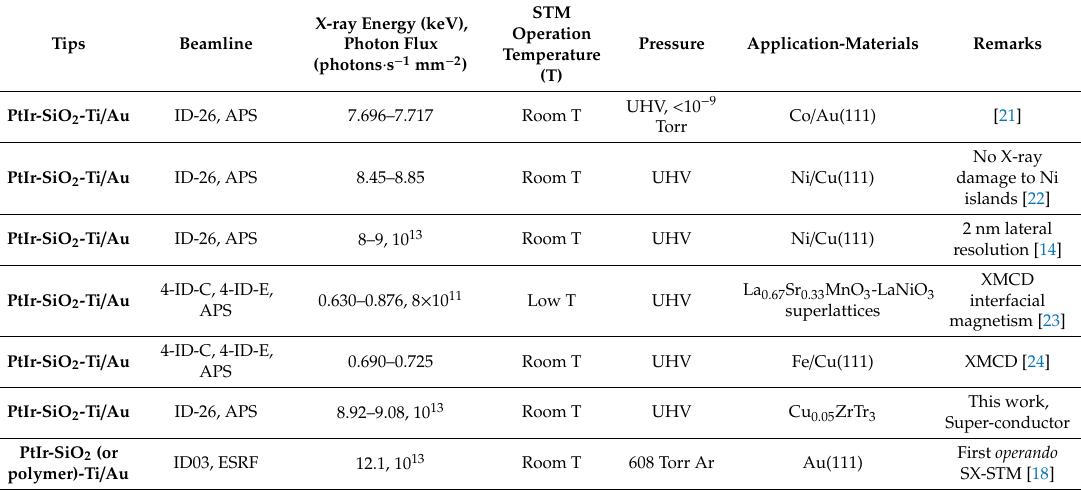
Table 2. Developed smart tips and their applications to the SX-STM studies since